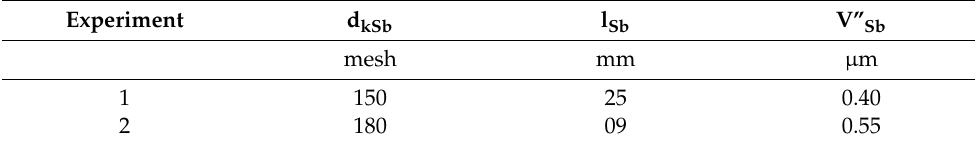
Table 5. Sharpening parameters for the verification of the process